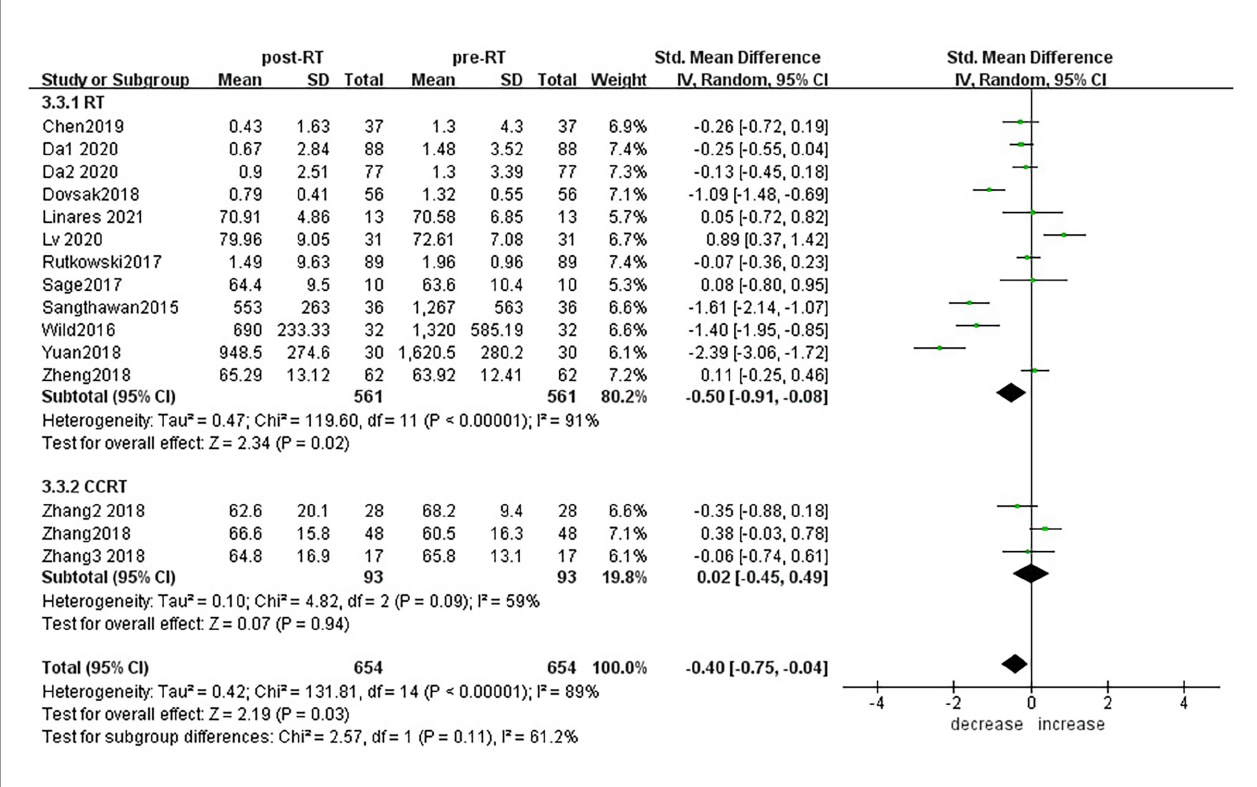
FIGURE 7 | Forest plots of subgroup analysis for changes of CD3+ T lymphocyte after radiotherapy compared with before radiotherapy in different treatment